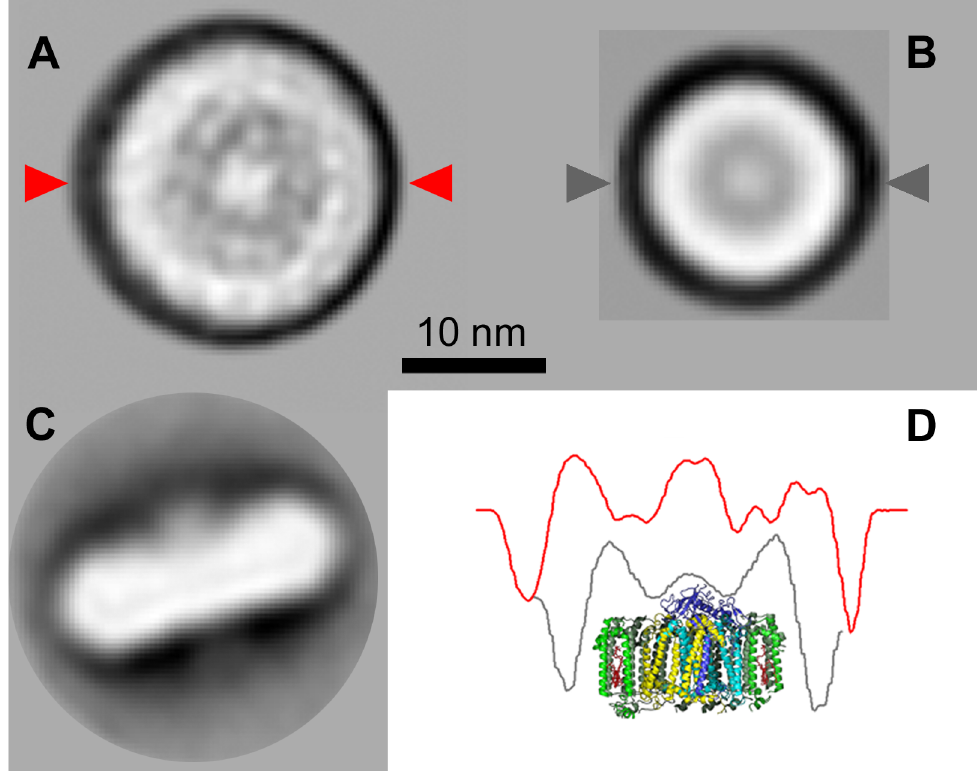
Fig 1. Top view projectionmaps of the PS complexes of G . phototrophica (A) and R . rubrum (B). Side view of an individualPS complex of G . phototrophica (C). Symmetric cross-sectional profile of the PS complexesof G . phototrophica (red line) and R . rubrum (grey line) super imposedon R . rubrum structural model (D). The position of the cross sections is indicatedby small triangleson the projectionmaps A and B. PS, photosynthetic.